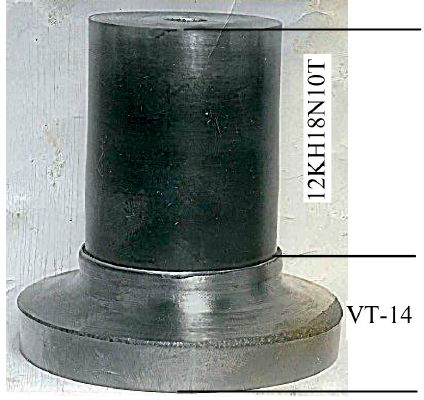
Figure 1. Welded bimetal adapter billet.